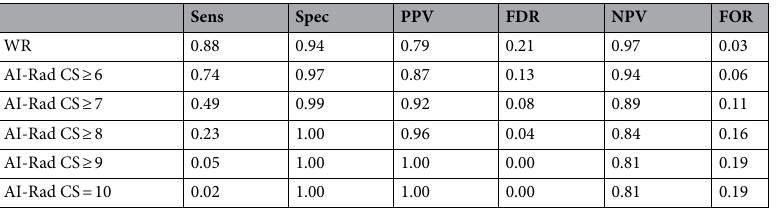
Table 7. Performance metrics of the radiologists (WR = written report) and the AI Rad Companion Chest X-ray (AI-Rad) for the detection of pleural effusions. CS confidence score, PPV positive predictive value, NPV negative predictive value, FDR false discovery rate, FOR false omission